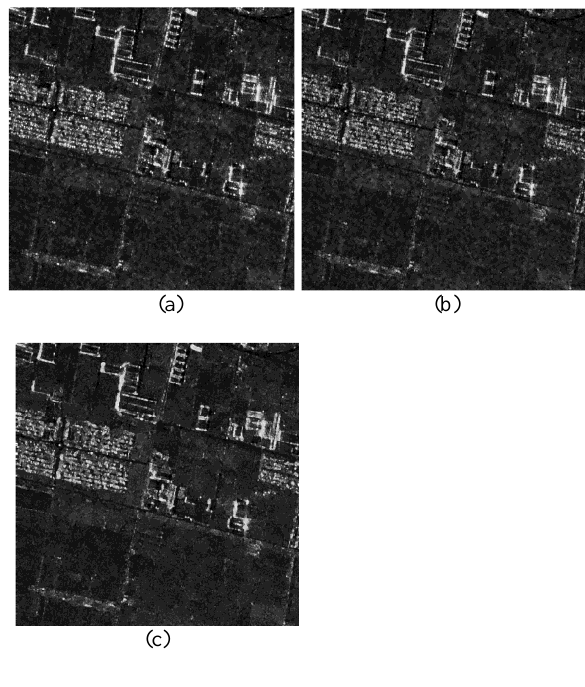
Fig 5. Despeckling result Image1: (a) Lee filter, (b) Gamma MAP filter, (c) Our method.